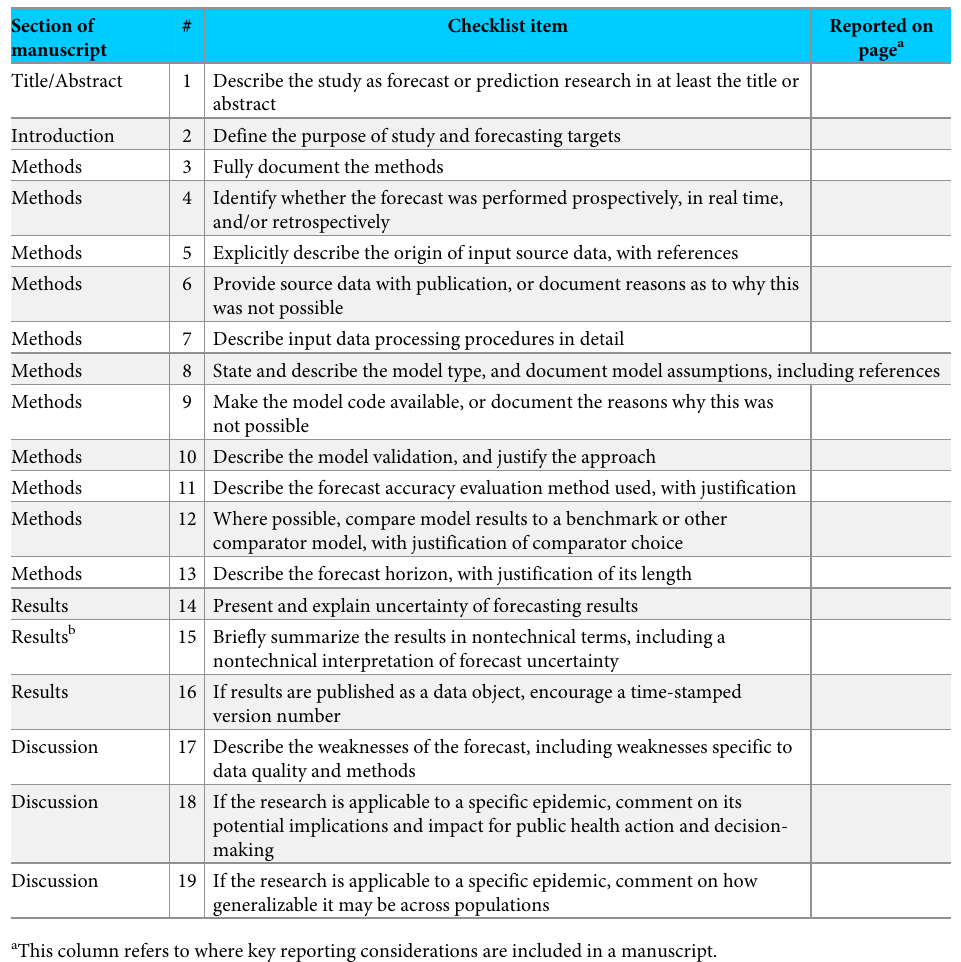
Table 1. EPIFORGE 2020